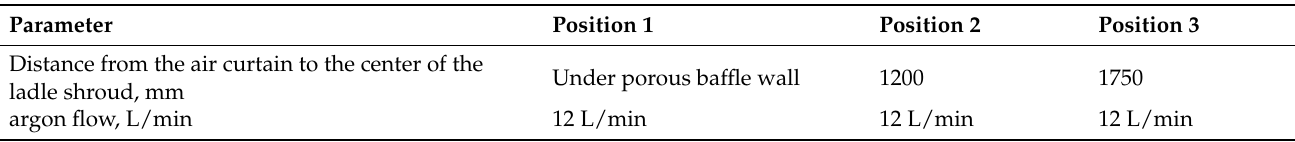
Table 3. Installation scheme of air